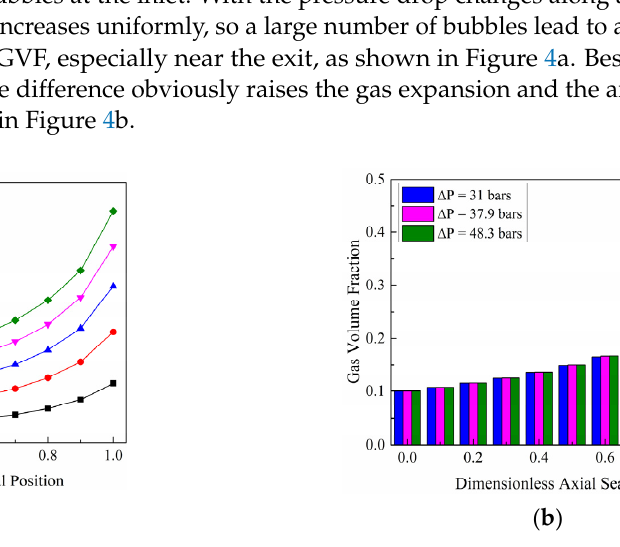
Figure 5. GVF distribution characteristics along the axial direction at specific regions. ( a ) Schematic diagram of the three specific regions, ( b ) GVF increment versus inlet GVF in regions 1, 2, and 3.